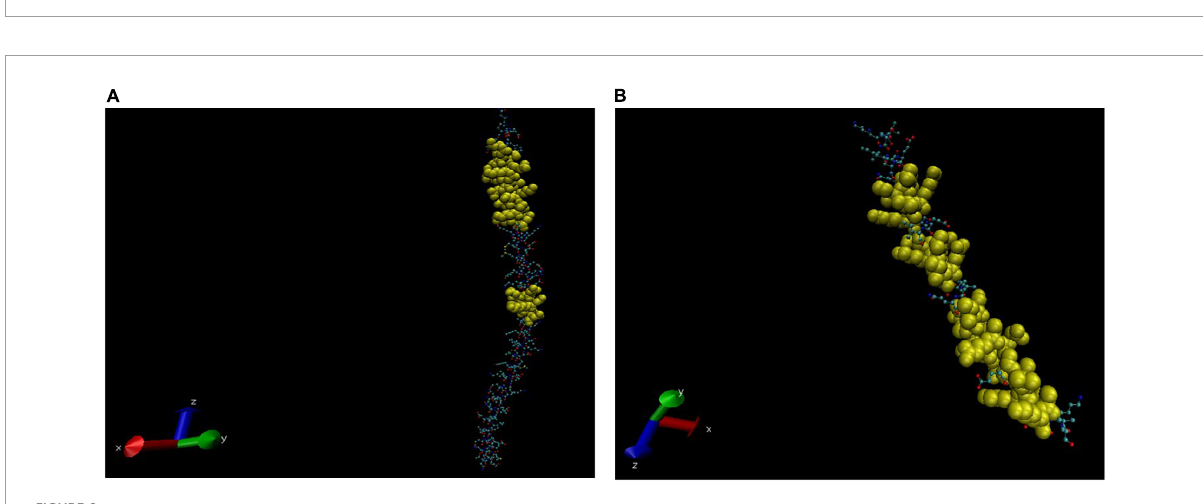
FIGURE6 Three-dimensional (3D) structure of Keratin 1. The BCEs are highlighted in yellow (A,B)